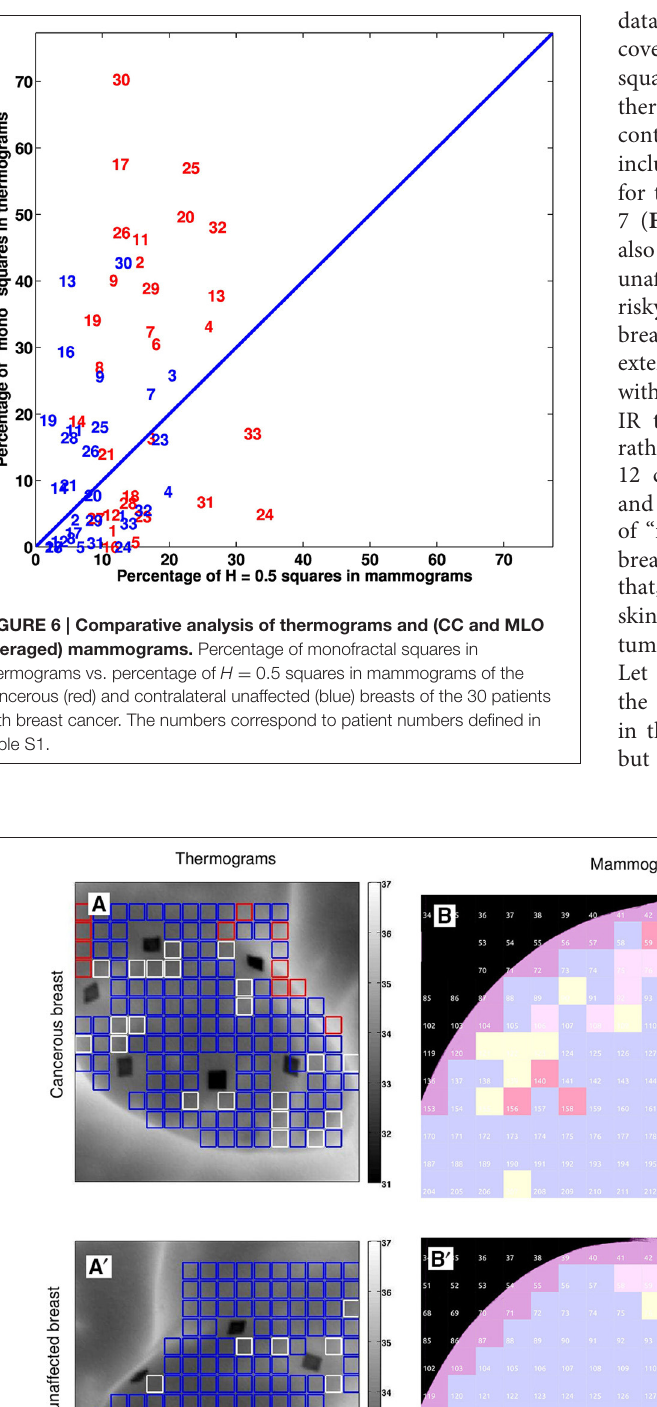
Frontiers in Physiology |